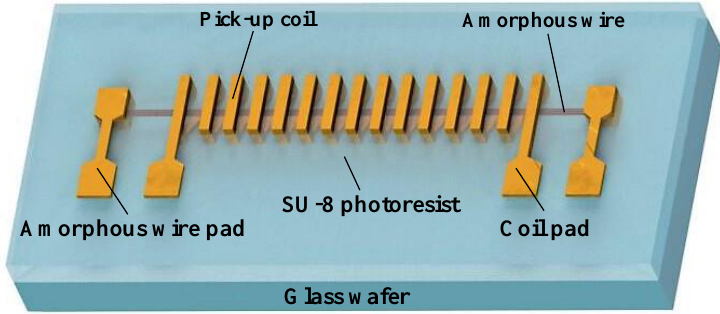
Figure 1. The three-dimensional model of sensor sensitive probe.